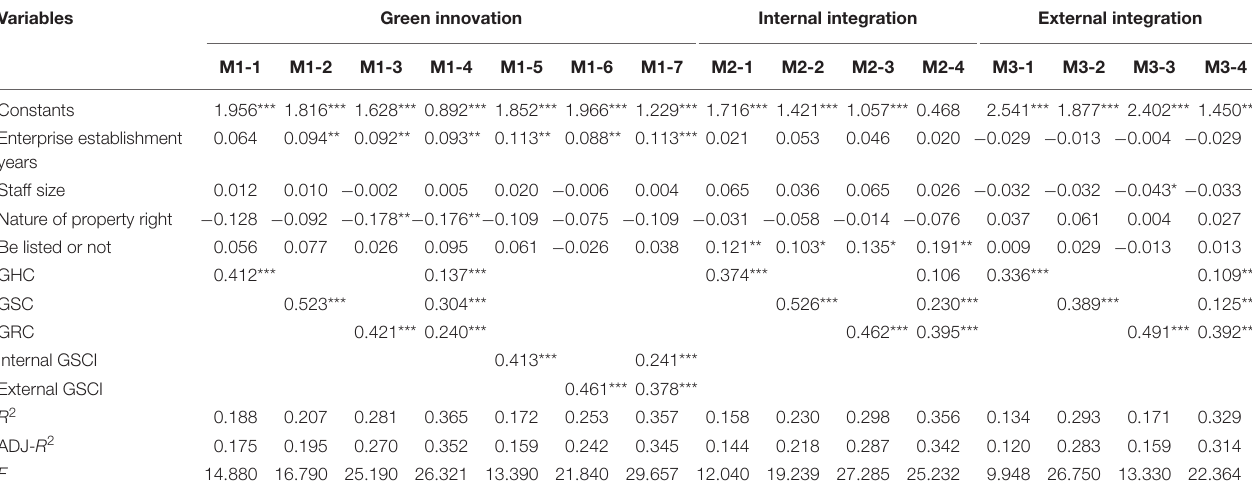
TABLE 4 | Results of the regression analysis (direct effects).